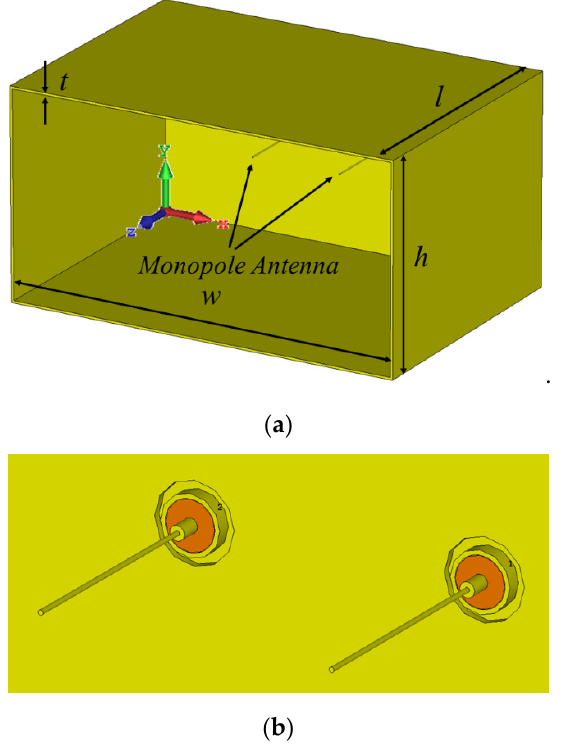
Figure 1. Open cavity. ( a ) Geometry of the 3D problem, including an open metallic cavity and two monopole antennas. The dimensions of the cavity are w = 25 cm, h = 13 cm, l = 17.4 cm, and t = 1.5 mm. ( b ) An expanded view of the two monopoles. The left and right monopoles are considered as the sensor and the source, respectively, in the EMTR method. The two monopole antennas are identical, with a length of 5.3 cm.